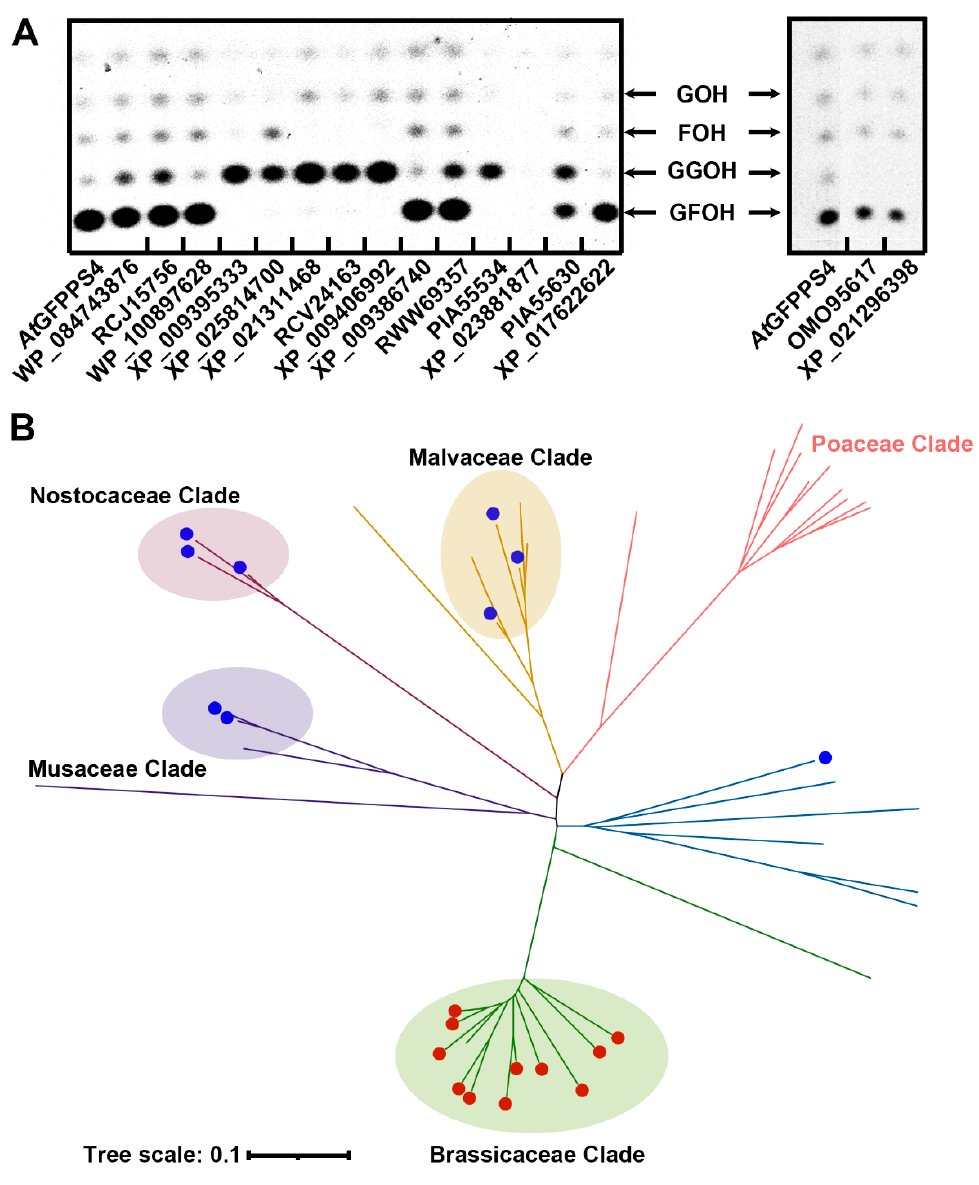
Figure 4. Identification and phylogenetic analysis of GFPPS homologs in plants. ( A ) In vitro enzymatic activities of predicted GFPPS candidates. All the predicted trans -PTs enzymes were characterized using DMAPP and [1–14C]-IPP as co-substrates; the products were analyzed using TLC. AtGFPPS4 was used as a positive control. ( B ) Phylogenetic analysis of potential GFPPSs predicted using PTS-Pre with experimentally identified GFPPSs from panel A. The GFPPSs from Arabidopsis thaliana are highlighted by red circles, and the GFPPSs identified in this study are highlighted by blue circles. The branches of the phylogenetic tree are colored according to different clades; Musaceae, Nostocaceae, Malvaceae, Poaceae, and Brassicaceae are colored with purple, firebrick red, yellow, red, and green, respectively.